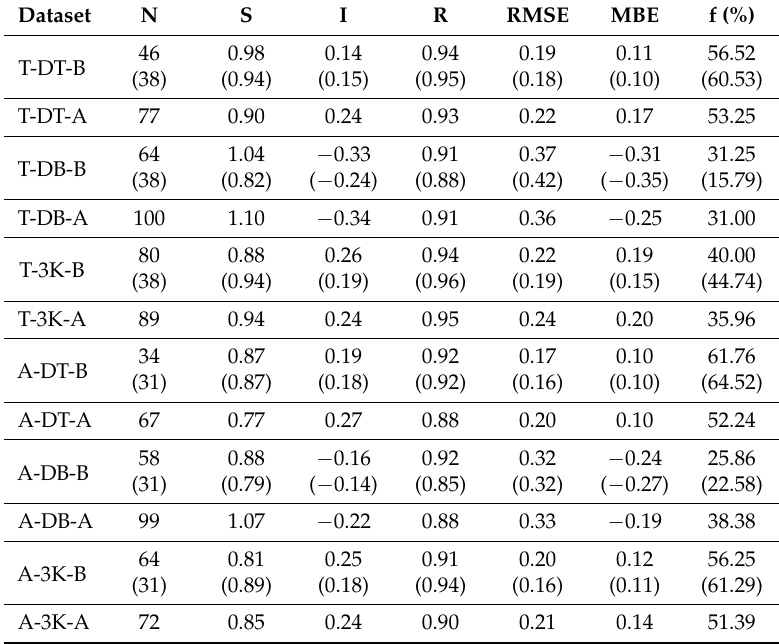
Table 1. Statistical results for the validations of Moderate Resolution Imaging Spectroradiometer (MODIS) aerosol optical depth (AOD) products against ground based sun photometer AODs. Numbers in parentheses are the results when both algorithms provide